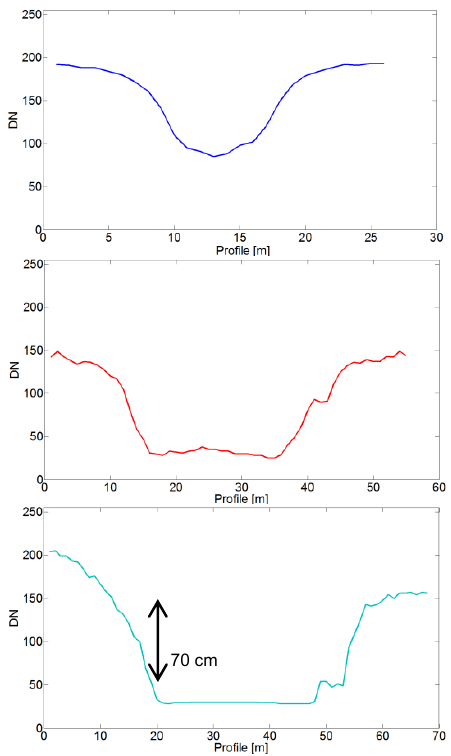
Figure 2. Typical profiles of tidal channels with different size in our test site. The digital numbers ( DN ) of the gray values of the DTM correspond to the heights z in the test site (here: DN = 0 and DN = 255 are equivalent to z = -0.02 m and z = 1.72 m, so 1 DN corresponds to about 0.007